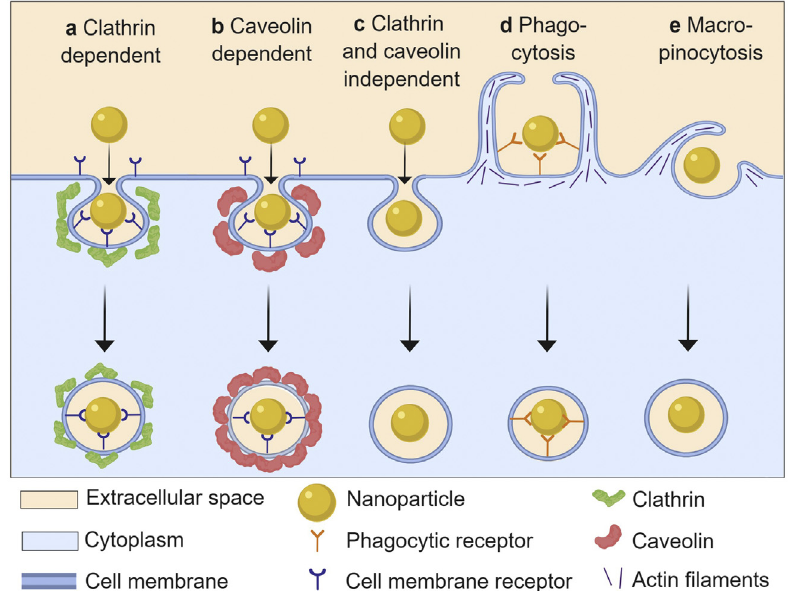
Figure 4. Schematic presentation of different endocytic pathways used by nanoparticles. The different uptake mechanisms dispose of nanoparticles intracellularly through different processes, and so the uptake mechanism has an important effect on intracellular activity and durability of metal oxide NP activity. Taken from Donahue et al. [106] with